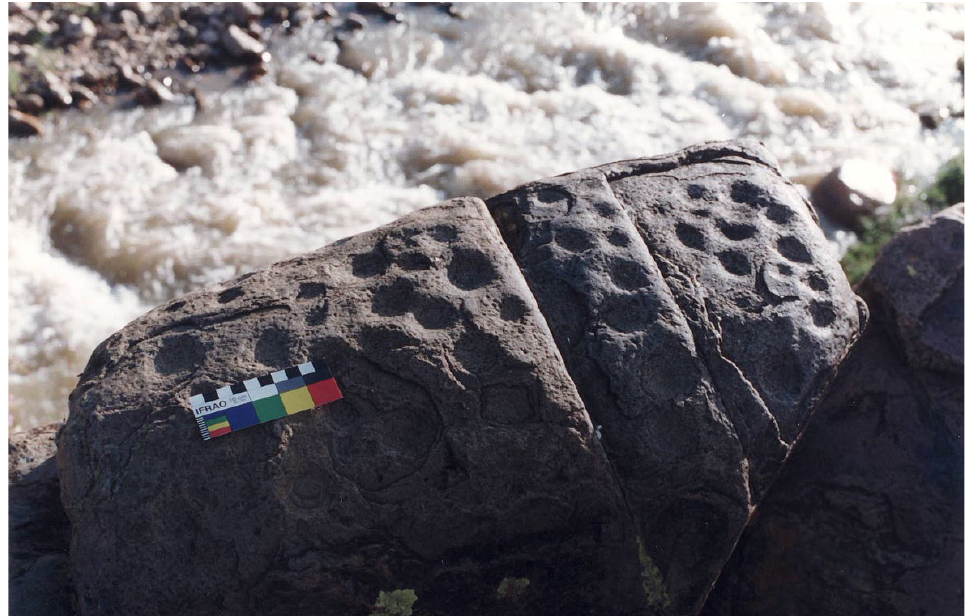
Figure 5. Oldest petroglyph tradition of Inca Huasi, Mizque valley, central Bolivia, probably early Holocene or very final Pleistocene.